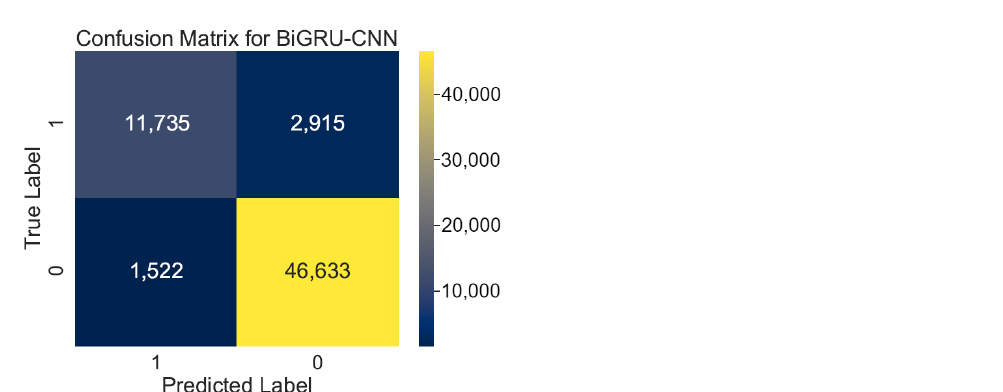
Figure 9. Confusion matrix for GRU and